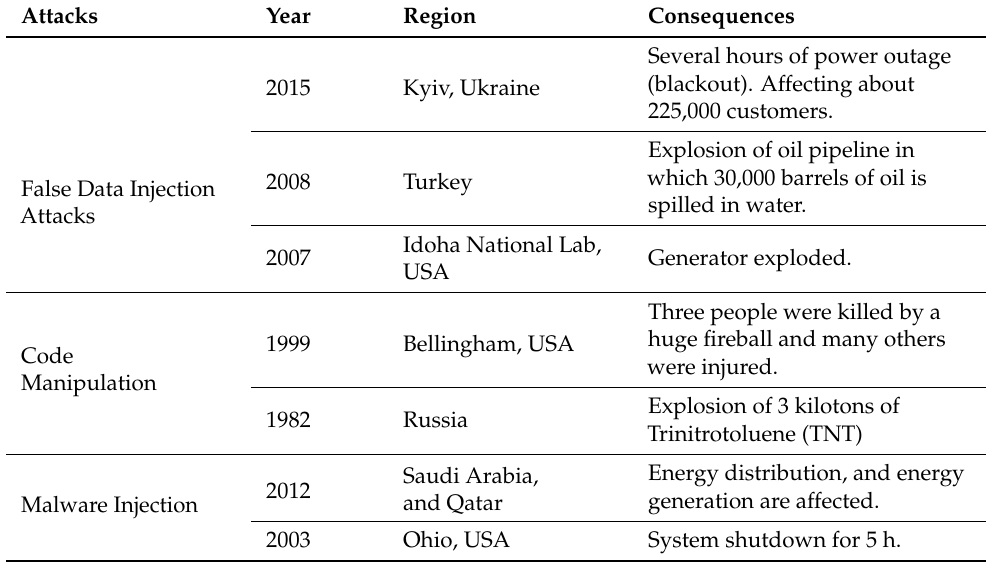
Table 1. Examples of cyber attacks on power systems